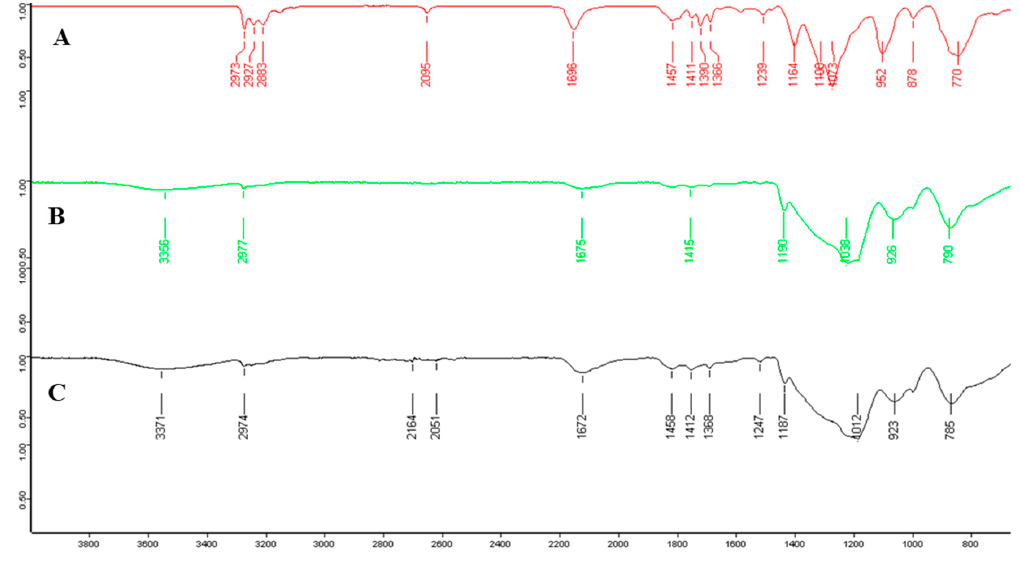
Figure 4. FTIR of ( A ) P2 , ( B ) E ‐ P2 90/10 and ( C ) E ‐ P2 75/25 .